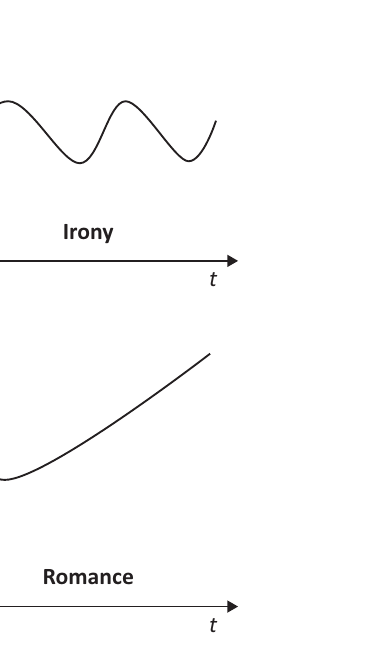
Figure 1. Schematic representation of narrative genre plot lines (own